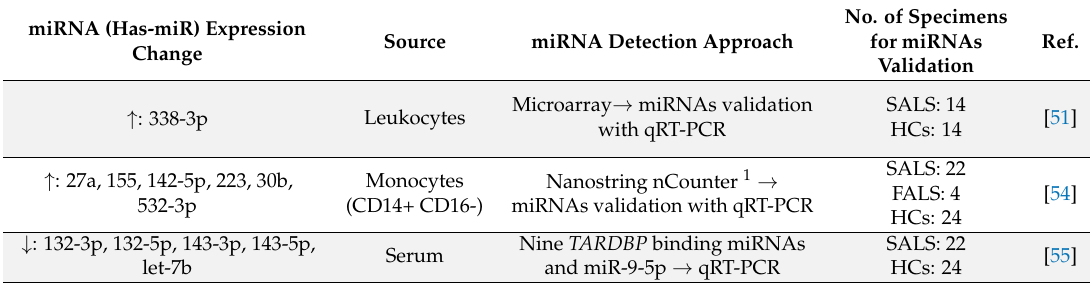
Table 2. Deregulated circulating microRNAs (miRNAs) in amyotrophic lateral sclerosis (ALS) patients compared to healthy